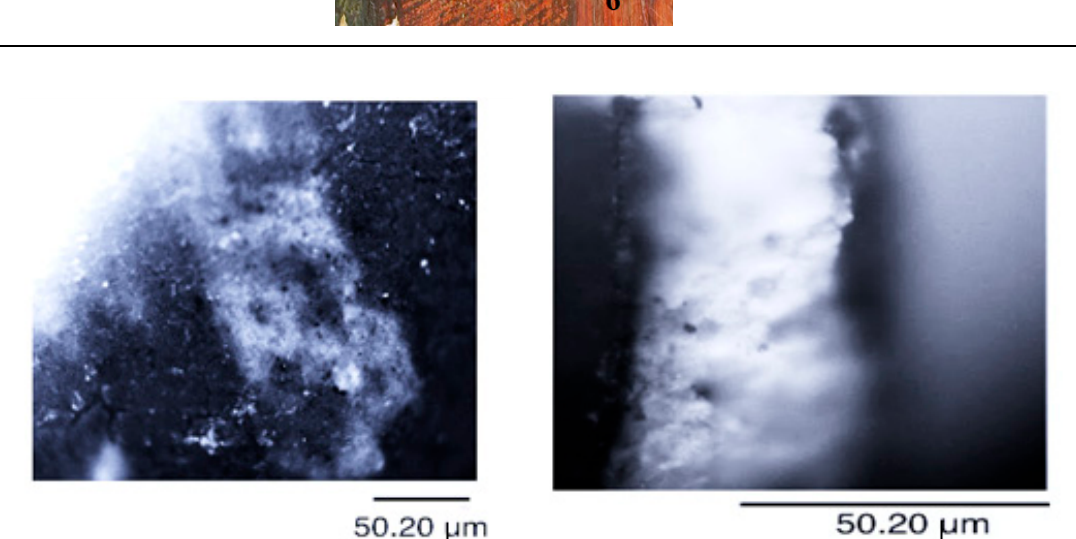
Figure 3. The optical microscopy of the efflorescence generated by blue pigments .